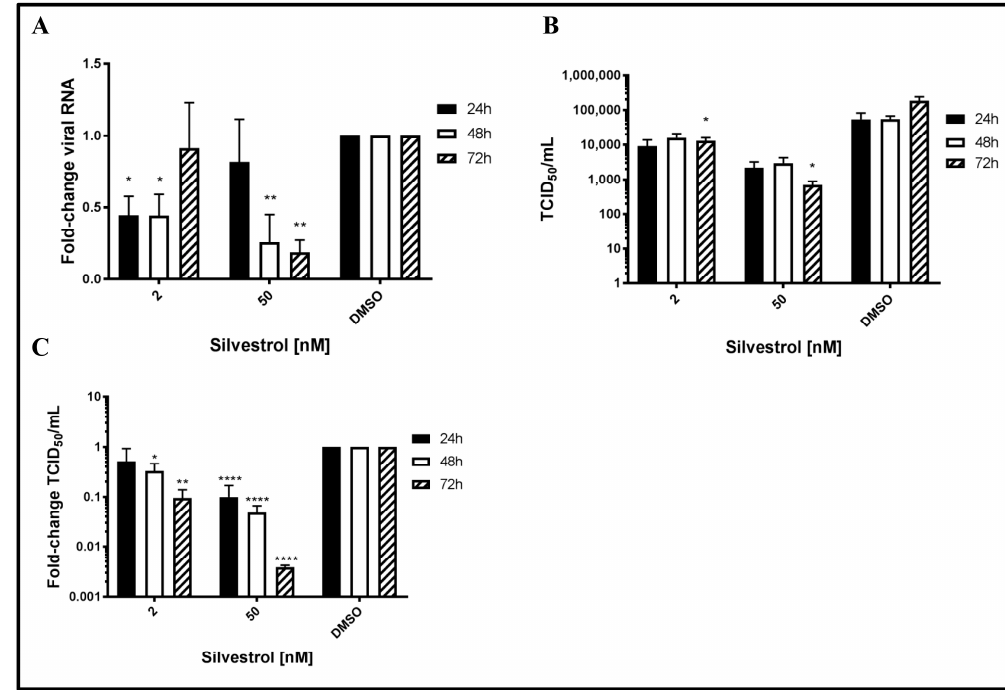
Figure 1. Repressive effect of silvestrol on release of infectious viral particles from A549 cells persistently infected with hepatitis E virus (HEV) strain 47842c. ( A ) qPCR quantification of extracellular viral RNA in the supernatant derived from silvestrol treated cells (2 nM and 50 nM). The values were referred to the DMSO control; ( B ) Absolute tissue culture infective dose (TCID 50 ) values determined after A549/D3 infection (logarithmic scale); ( C ) Relative TCID 50 values compared to DMSO on the basis of ( B ). n = 3 for all experiments; * p < 0.05, ** p < 0.01, **** p < 0.0001.